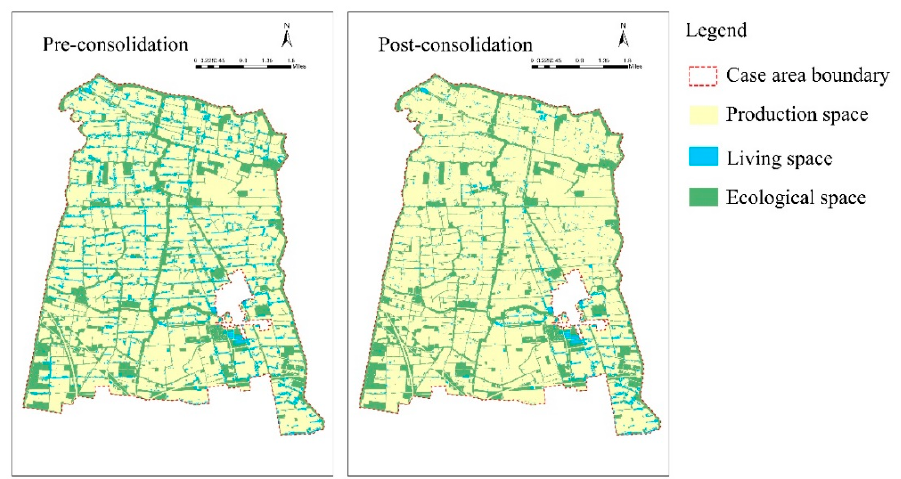
Figure 2. Spatial utilization before and after comprehensive land consolidation in Gaozuo